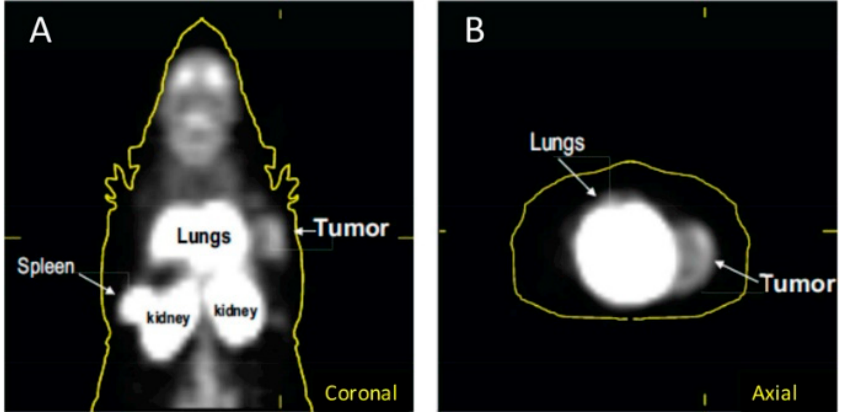
Figure 2. [ 11 C]PBR28 uptake in a mouse model of pancreatic ductal adenocarcinoma(PDAC) in ( A ) coronal images and ( B ) axial images. From Lanfranca, M.P., et al. [53] used with permission.